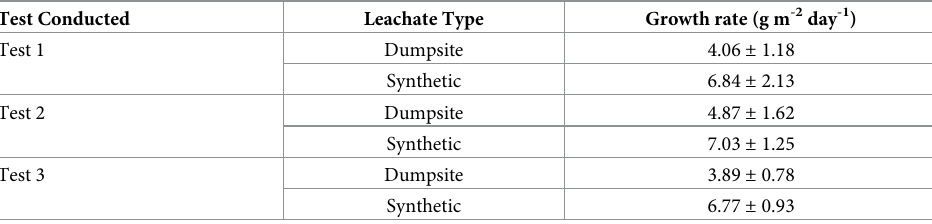
Table 4. Comparison of duckweed growth rates on synthetic and dumpsite leachate during three